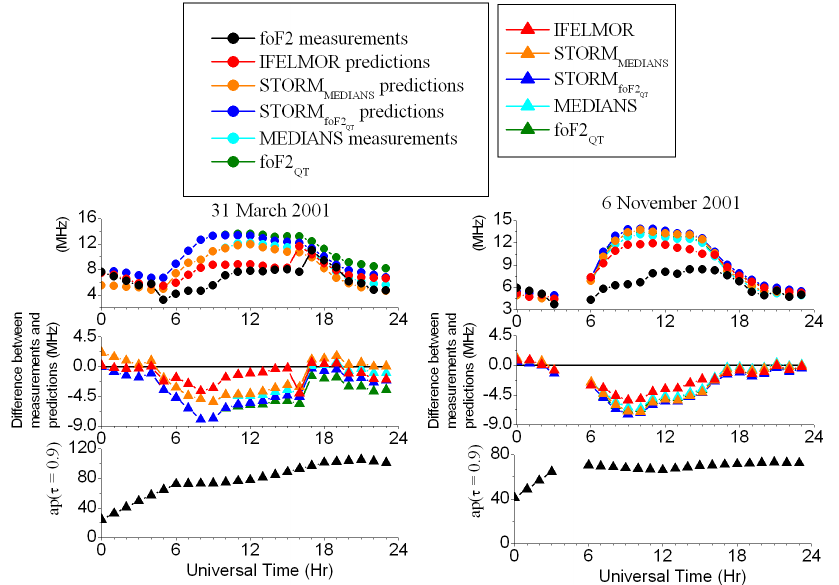
Fig. 9. Same as Fig. 8, but for disturbed ionospheric conditions on 31 March and 6 November 2001. IFELMOR provides much better predictions than both STORM MEDIANS and the median measurements, in particular, IFELMOR’s performance is significantly better with respect to STORM fo F2 QT and fo F2 QT especially for 31 March 2001 as is confirmed by the values of the r.m.s. reported in Tables 4–5.